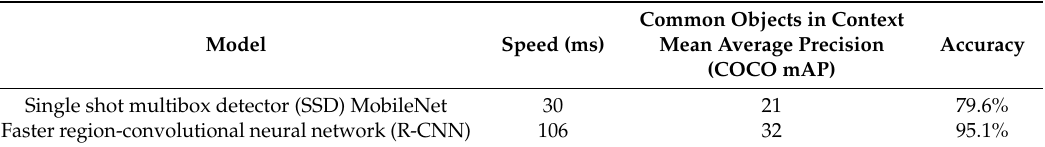
Table 2. Comparison of obstacle recognition